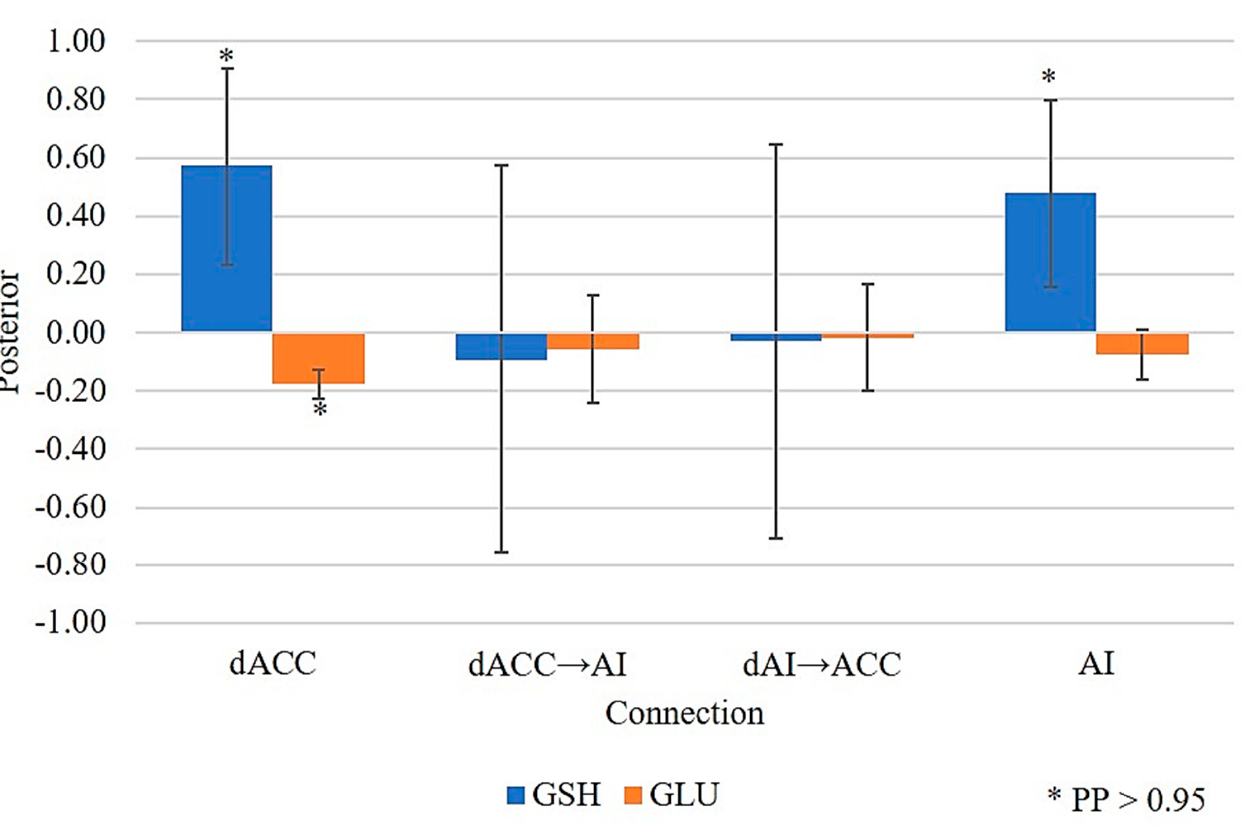
Figure 4. Counteracting effect of the GSH on the hyperglutamatergic state in the dACC–AI network. As previously reported [14], in the dACC the effect of GLU on IE connections (see also Figure 2 for reference) was weaker in FES patients than in HC subjects (indexed by the negative parameter estimate). This indicates stronger disinhibition of excitatory neuronal population with higher levels of GLU in patients than in controls, leading to a hyperglutamatergic state. Crucially, positive parameter estimates in blue indicate the effect of GSH on inhibitory (i.e., GABAergic) activity within the dACC and AI, this effect being stronger in FES patients than in HC subjects. Since the net activity of a given neuronal population is a linear function of the relevant parameter estimates, the magnitudes of these estimates indicate that the glutamatergic influence on intrinsic connectivity in the dACC is compensated by the “antioxidative” state.